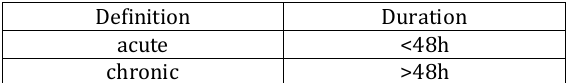
Table 2. Definition of hyponatremia, depending on